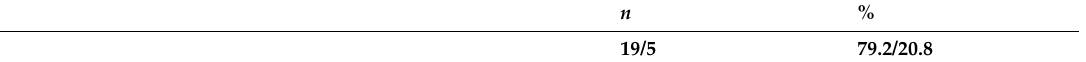
Table 1. Patients and disease characteristics and medications, n = 24.